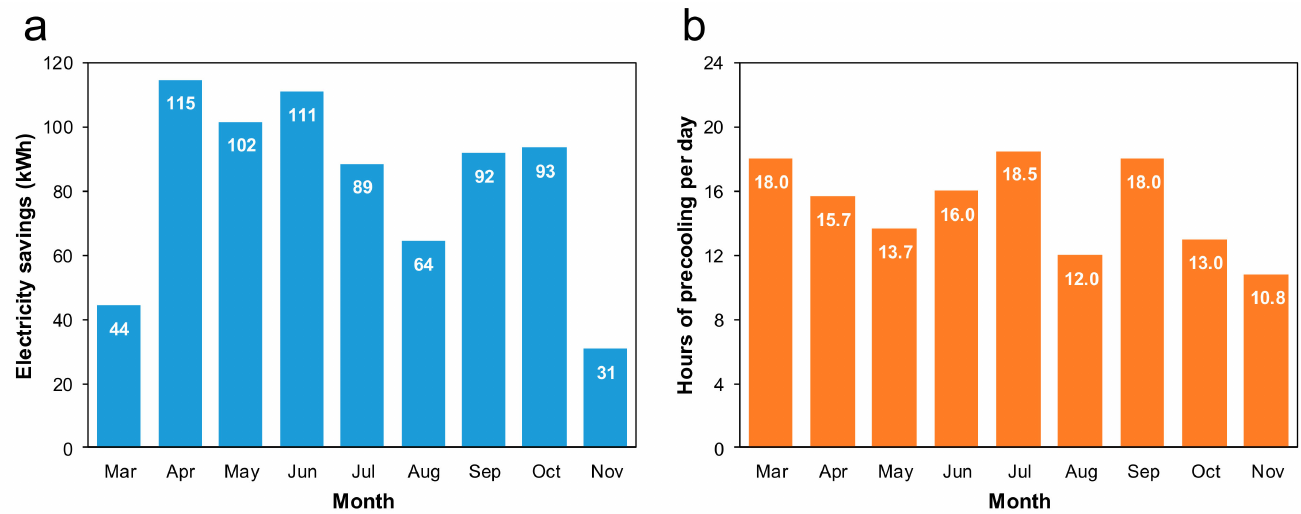
Figure 11. ( a ) Predicted electricity savings resulting from using the EAHE as a precooler. ( b ) Average daily operating hours of the